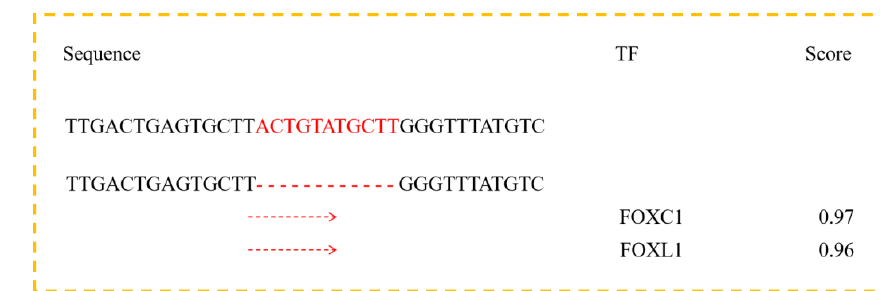
Figure 2. Bioinformatics predict transcription factor binding sites on the bovine DYRK2 gene 11bp InDel sequences.